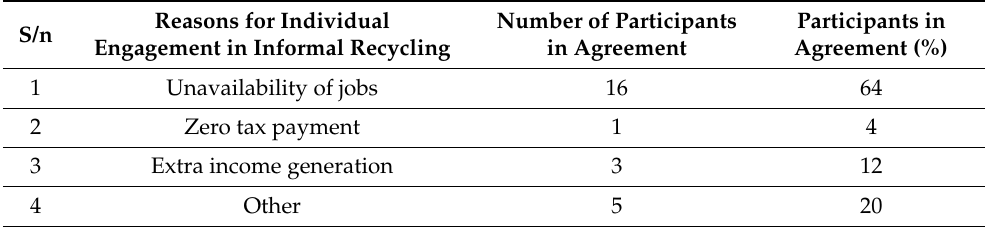
Table 5. The reasons why informal recyclers engage in WEEE management. Reasons for Individual S/n Engagement in Informal